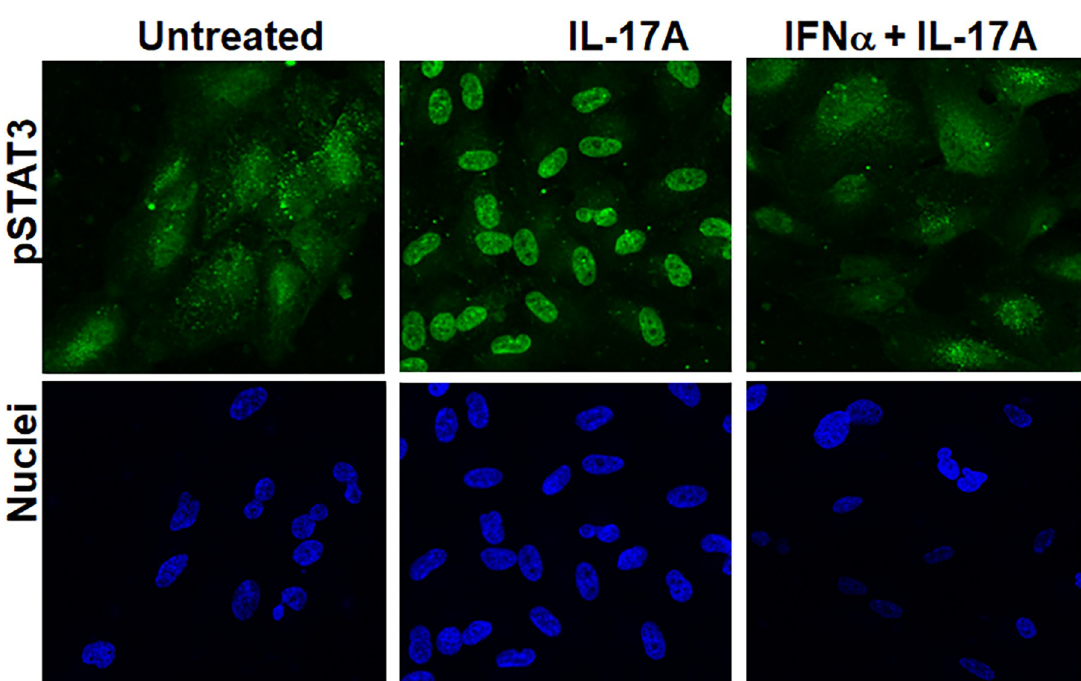
Fig 3. IFN α -C prevented signaling from IL-17A. ARPE-19 cells were seeded on 8 well microscopic slides and grown overnight. They were placed in low serum medium and treated with IFN α -C (3 μ M) for 2 hr followed by treatment with IL-17A (50 ng/ml) for 30 min. Cells were fixed, permeabilized with 1% Triton X-100 (in PBS) and stained with an antibody to pSTAT3, followed by staining with Alexa 488-conjugated secondary antibody and DAPI and imaged in a fluorescence microscope at 40x